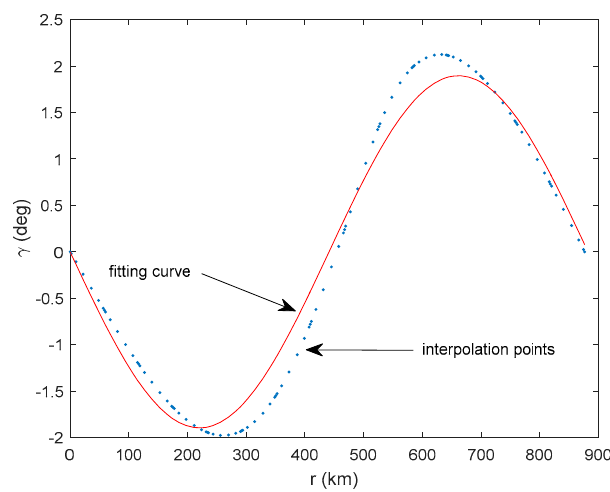
Figure 3. Optimal elevation angle at the initial altitude of 45 km.